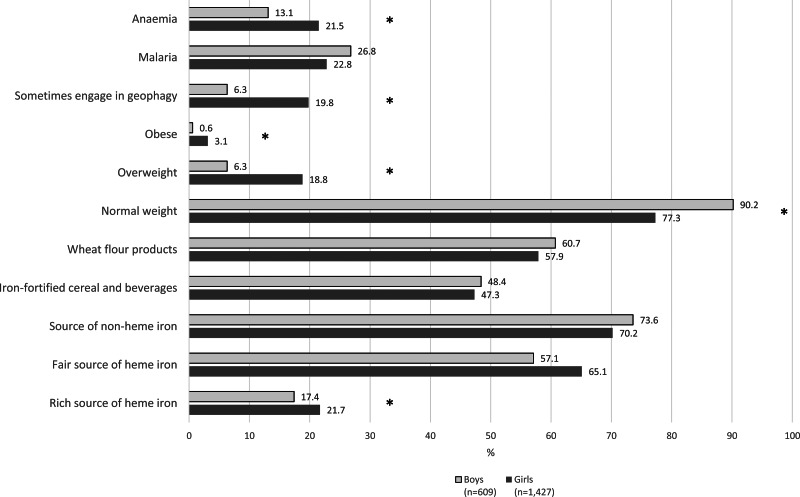
Characteristics of adolescent girls and boys in Ghanaian Schools in Upper West, Western and Western North regions. Note: *P < ⋅05. Values are weighted. Complex survey procedures used to account for clustering. Data for boys only available for Upper West, Western and Western North regions. Rich sources of haeme iron included red meats and organ meats; fair sources of haeme iron included white meats/poultry, eggs and fish; sources of non-haeme iron included dark green leafy vegetables, legumes and seeds; fortified foods included cereals such as Nestle Cerelac and beverages such as Nido and Milo; anaemia was defined using age-/sex-specific haemoglobin concentration cut-off values (children 10–11 years: Hb < 11⋅5 g/dl; girls ≥ 12 years and boys 12–14 years: Hb < 12⋅0 g/dl; boys ≥ 15 years: Hb < 13⋅0 g/dl).